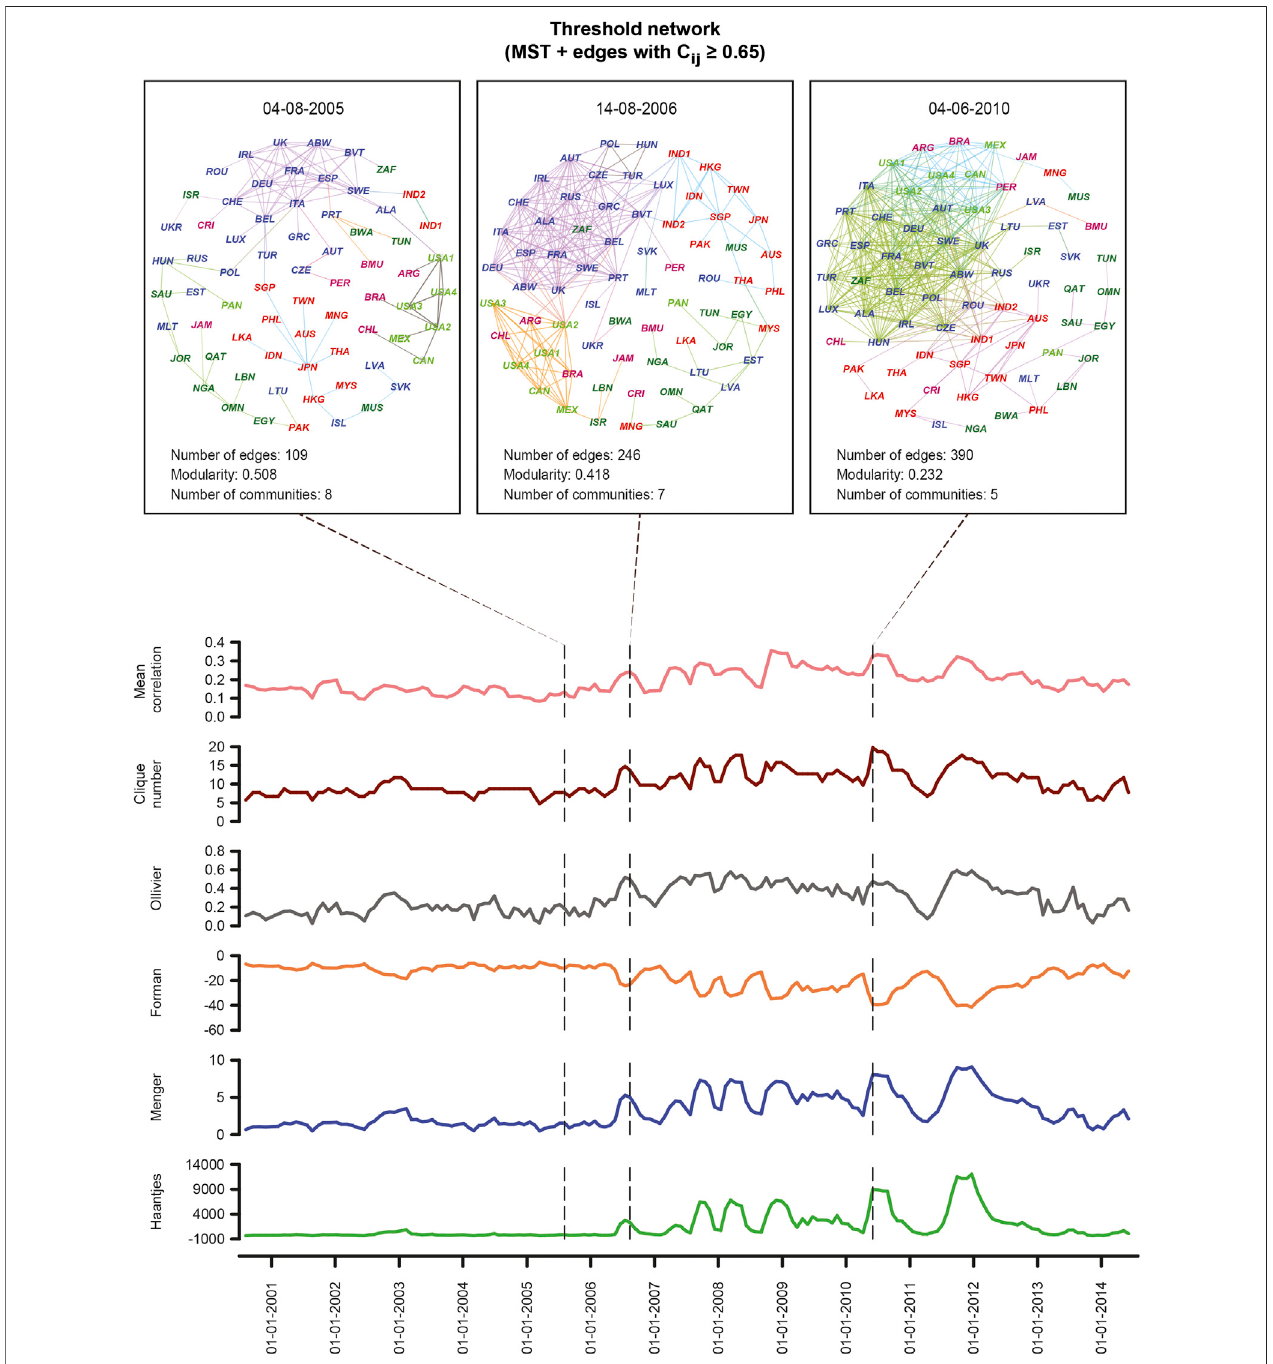
FIGURE2| Evolutionofnetworkcharacteristicsandvisualizationofthethresholdnetworks S τ ( t )ofmarketindiceswithawindowsizeof τ (cid:1) 80 daysandanoverlapping shift of Δ τ (cid:1) 20 days, constructed by adding edges with correlation C τ ij ( t ) ≥ 0 . 65 to the MST. (Lower panel) Comparison of the plots of mean correlation among market indices, clique number, average of Ollivier-Ricci (OR), Forman-Ricci (FR), Menger-Ricci (MR), and Haantjes-Ricci (HR) curvature of edges in threshold networks over the 14- year period. (Upper panel) Visualization of the threshold networks at three distinct epochs of τ (cid:1) 80 days ending on trading days t equal to August 4, 2005 (normal), August14, 2006(UShousingbubble), and June4,2010(DowJones fl ashcrash).Thresholdnetworksshowahighernumberofedges and alower numberofcommunities during the crisis. Correspondingly, there is an increase in mean correlation, clique number, average OR, MR, and HR curvature, and a decrease in average FR curvature of thresholdnetworksduringthe fi nancialcrisis.Nodecolorsandlabelsarebasedongeographicalregionandcountry,respectively,oftheindicesandedgecolorsarebasedon thecommunitiesdeterminedbytheLouvainmethod.ThefourUnitedStatesmarketindices,NASDAQ,NYSE,RUSSELL1000,andSPX,arelabeledasUSA1,USA2,USA3, and USA4, respectively, while the two Indian indices, namely, NIFTY and SENSEX30, are labeled as IND1 and IND2, respectively.